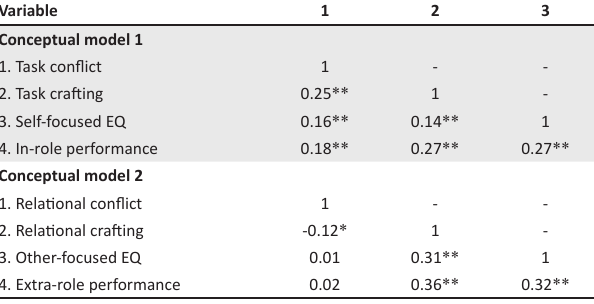
TABLE 1: Pearson’s correlations analysis. Variable Conceptual model 1